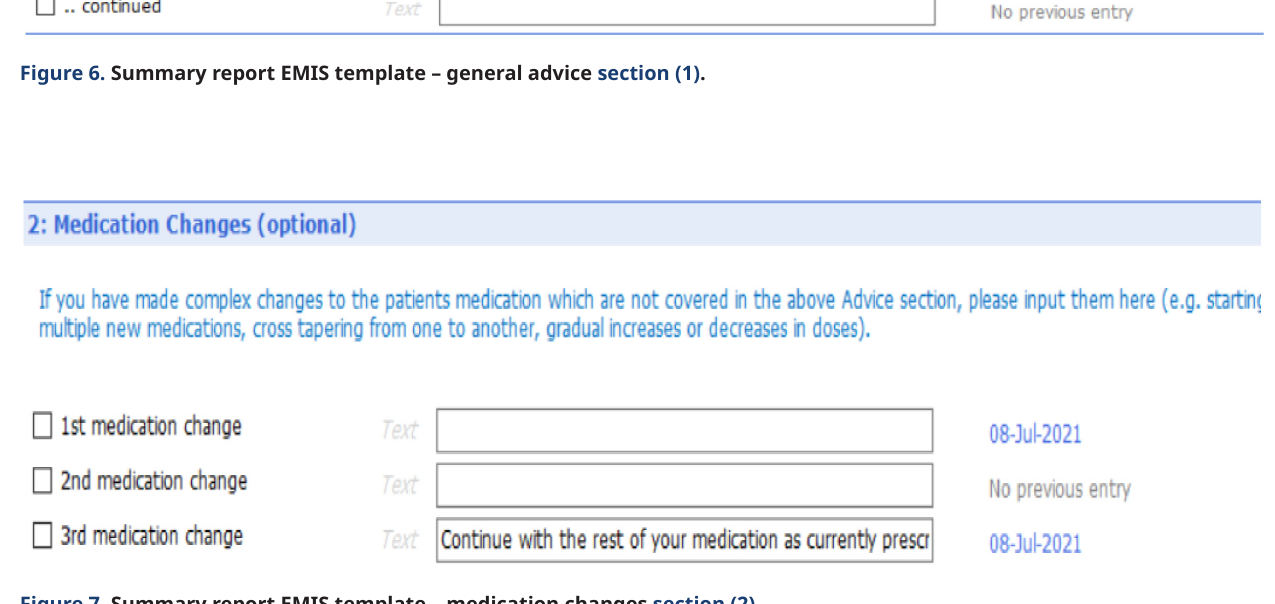
Figure 7. Summary report EMIS template – medication changes section